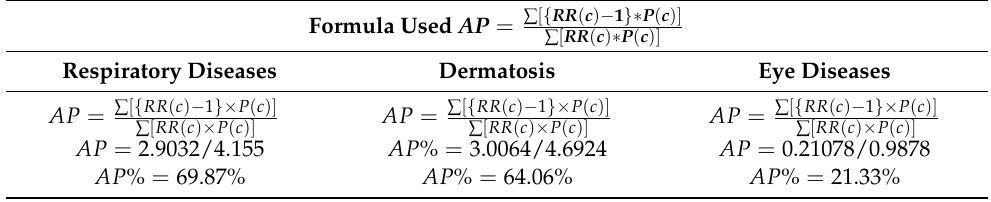
Table 1. Attributable proportion of diseases prevalence due to exposure to ozone for industrial units of Hattar Haripur Pakistan ( AP